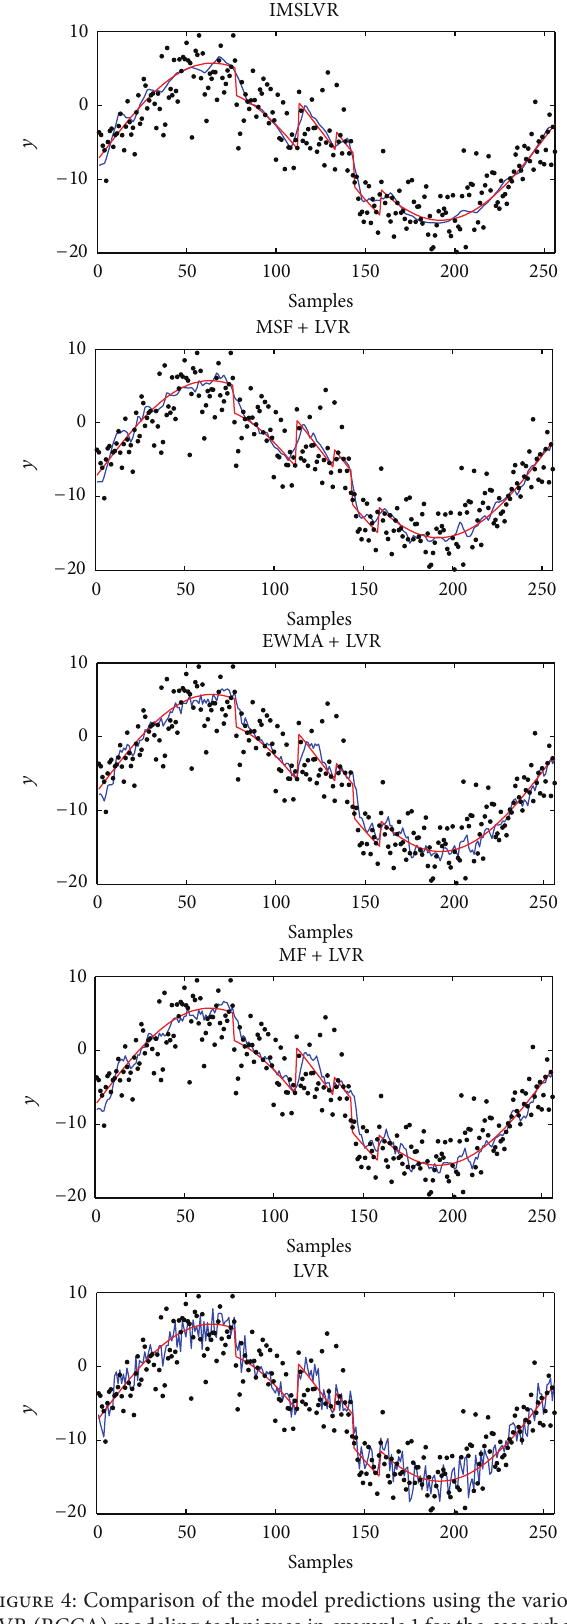
Figure 4: Comparison of the model predictions using the various LVR (RCCA) modeling techniques in example 1 for the case where SNR = 10 (solid blue line: model prediction; solid red line: noise- free data; black dots: noisy